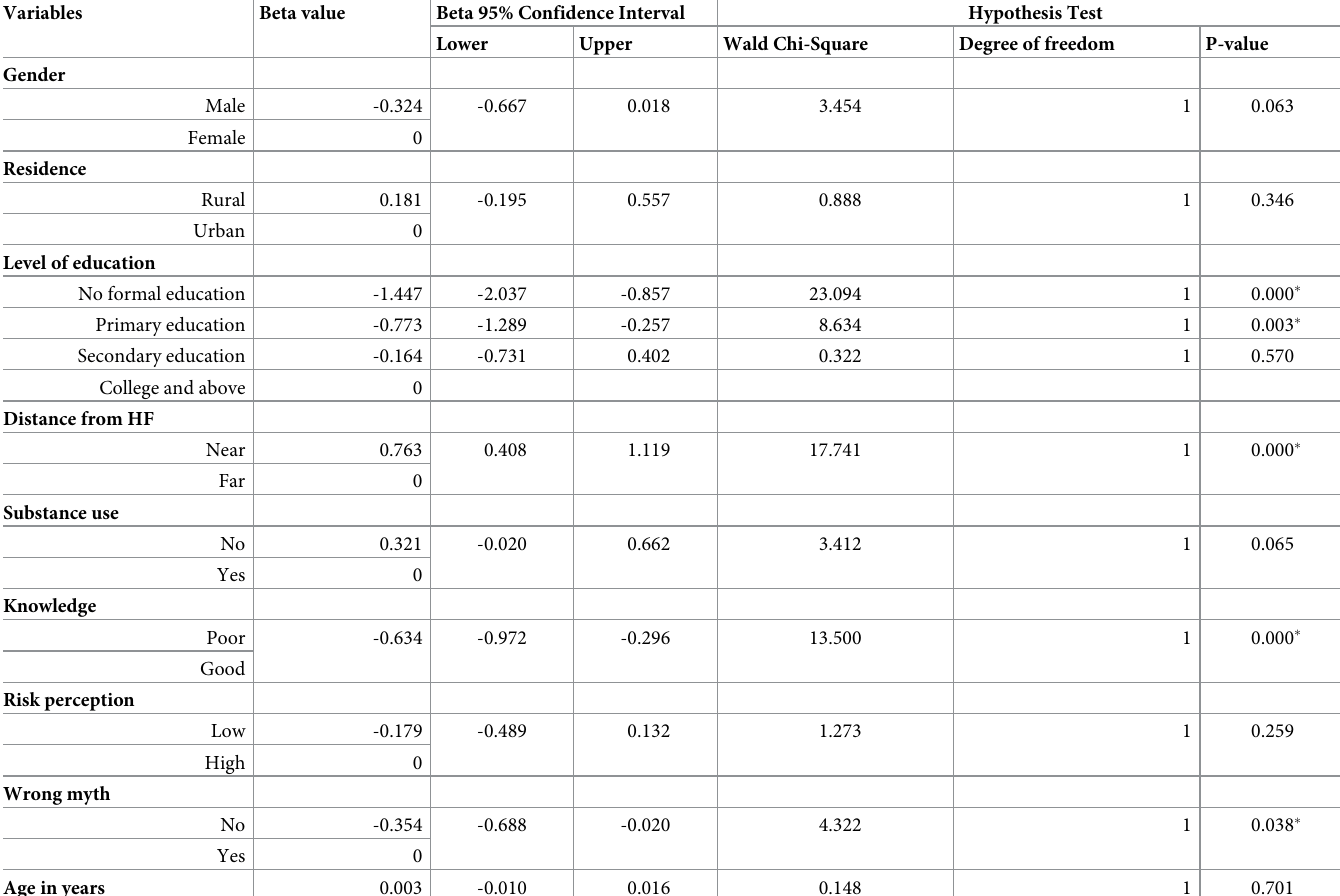
Table 5. Generalized linear model results of factors associated utilization of COVID-19 pandemic preventive measures, East Bale and Bale Zone Southeast